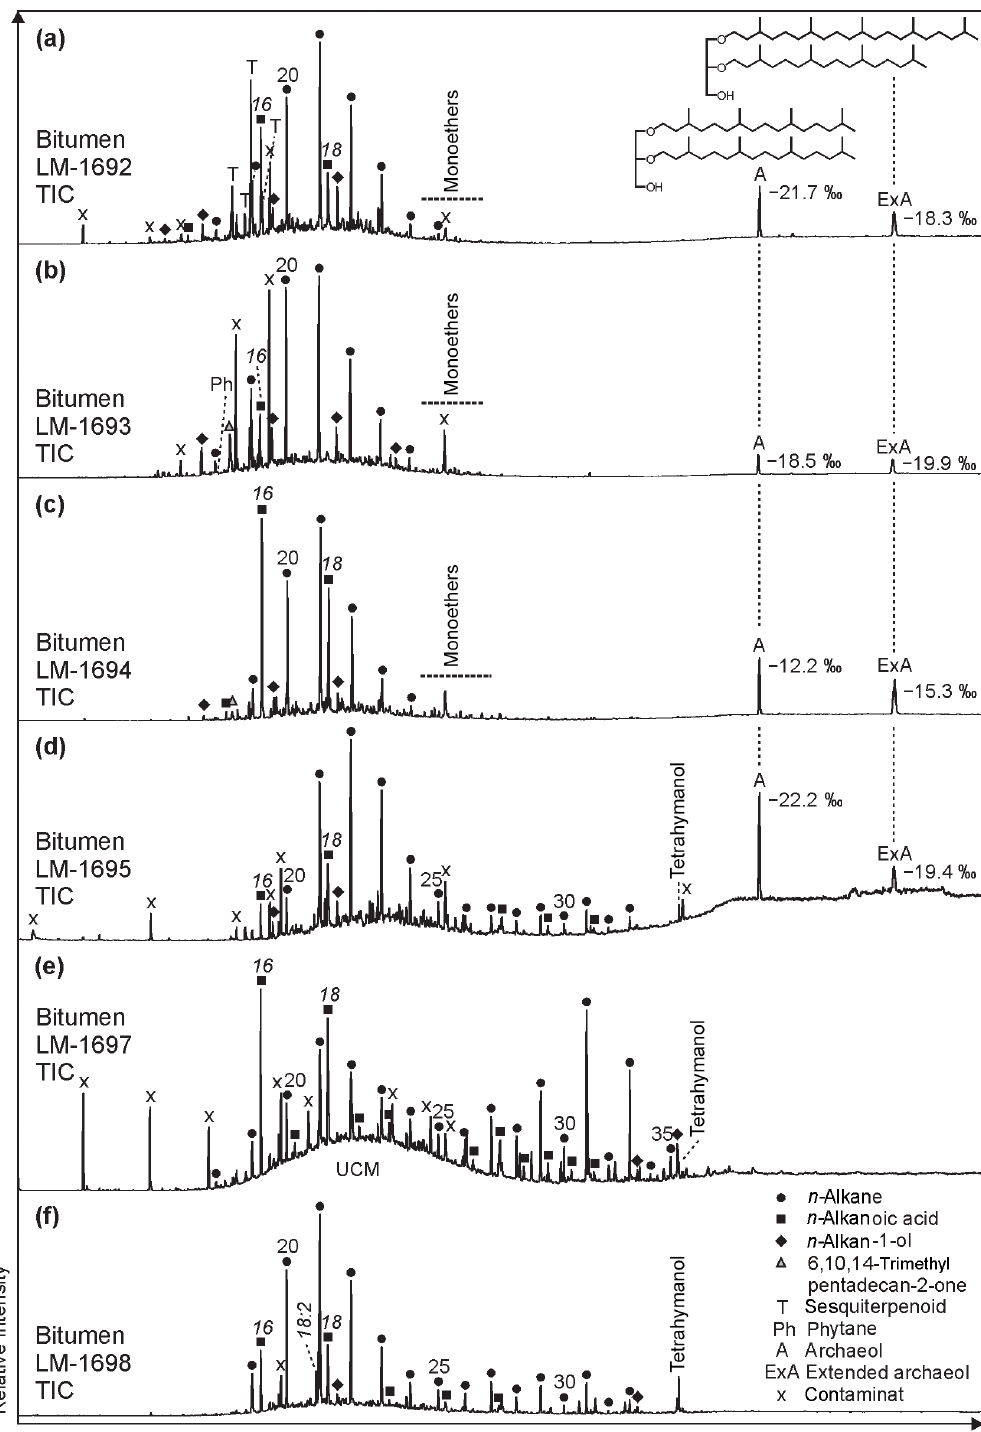
Figure 3. Total ion chromatograms (TICs; 10–65min) of the derivatized bitumens (alcohols were measured as trimethylsilyl ethers, car- boxylic acids as methyl esters) from the High Magadi Bed cherts (a–d) and the Green Bed cherts (e, f) . Note pronounced n -alkanes showing a bell-shaped distribution in the medium-chain range (maxima at n -C 20 , n -C 21 , or n -C 22 ) in all chromatograms except LM-1697 (maximum at n -C 31 ) . Other prominent compounds are hexa- and octadecanoic acid (all samples), tetrahymanol (LM-1695, LM-1697, LM-1698), glyc- erol monoethers (LM-1692–1694), and the glycerol diethers archaeol ( δ 13 C V-PDB between − 12 . 2‰ and − 22 . 2‰) and extended archaeol ( δ 13 C V-PDB between − 15 . 3‰ and − 19 . 9‰; LM-1692–1693 and LM-1695). Siloxanes and phthalates were identified as